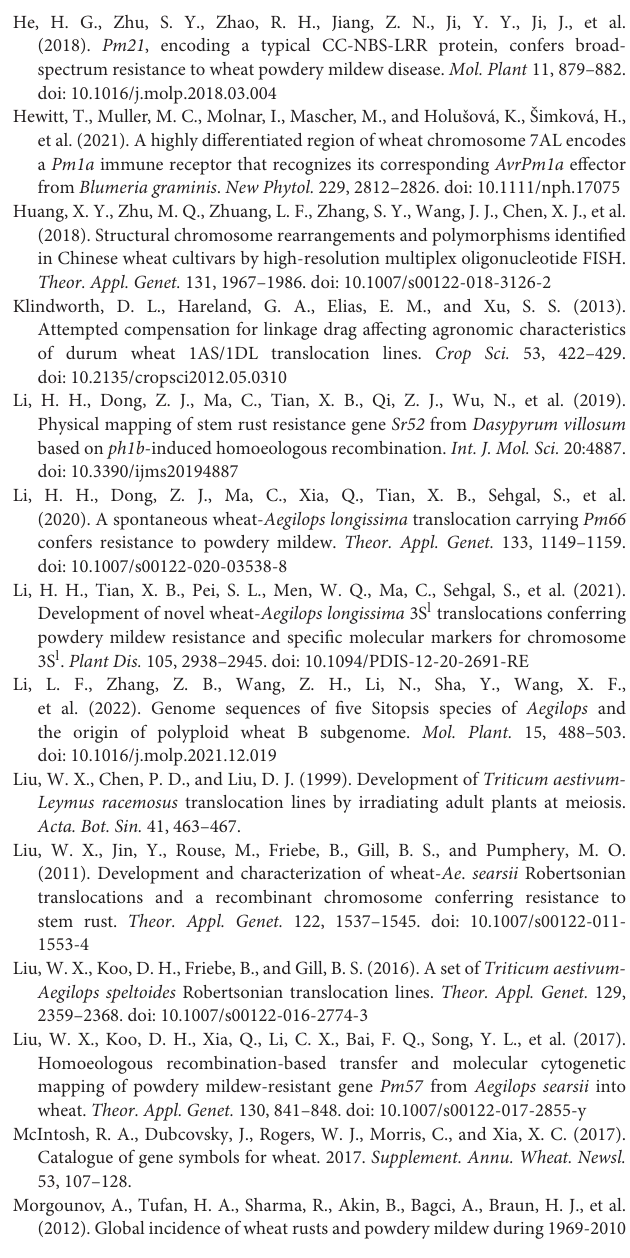
Supplementary Table S1 | SSR primers used in this